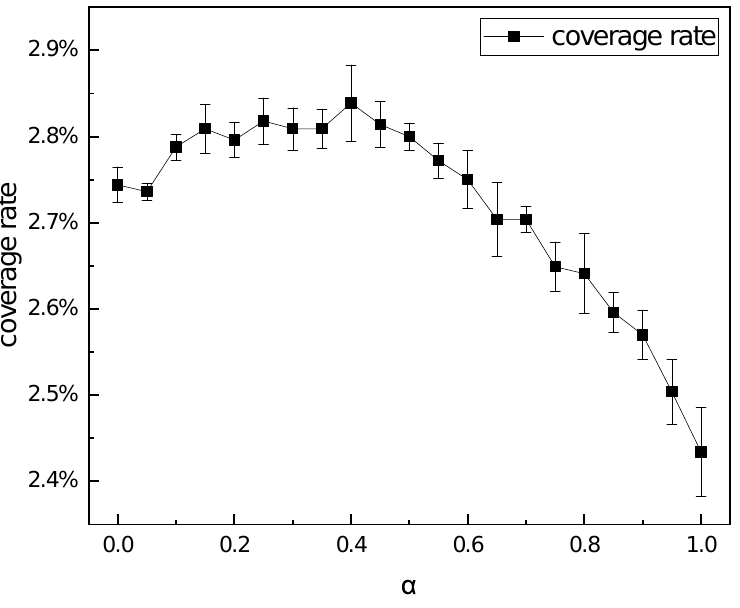
Figure 6. The coverage rate of 10 7 passwords with different hyperparameter α